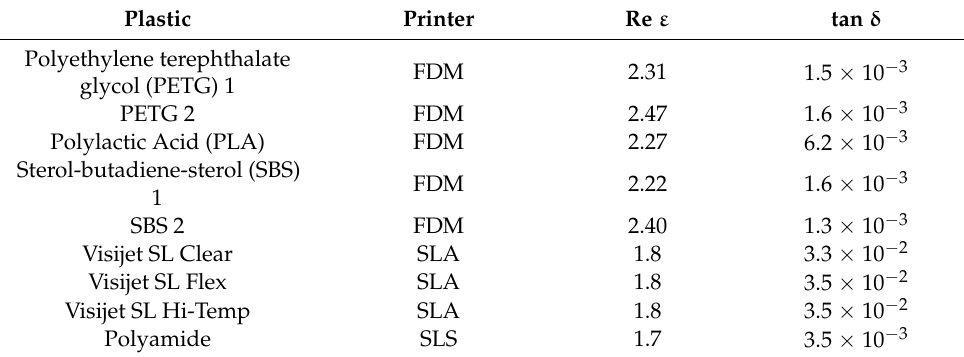
Table 1. Dielectric properties of the 3D-printed samples in Ka-band.